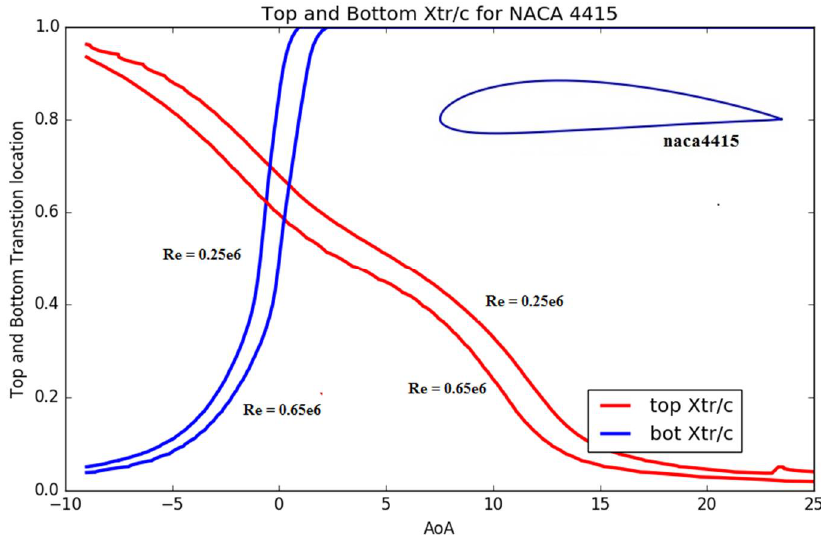
Figure 5. Transition location (Xtr/c) on top and bottom surfaces of NACA4415 at various REYN (Xfoil).